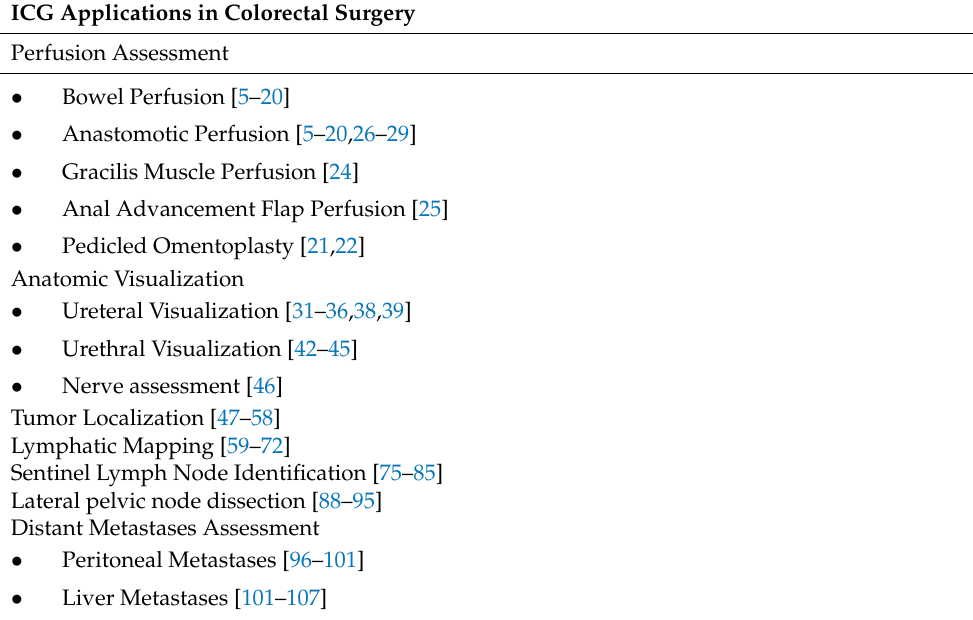
Table 1. Reported applications of indocyanine green (ICG) imaging in colorectal surgery in literature. ICG Applications in Colorectal Surgery Perfusion